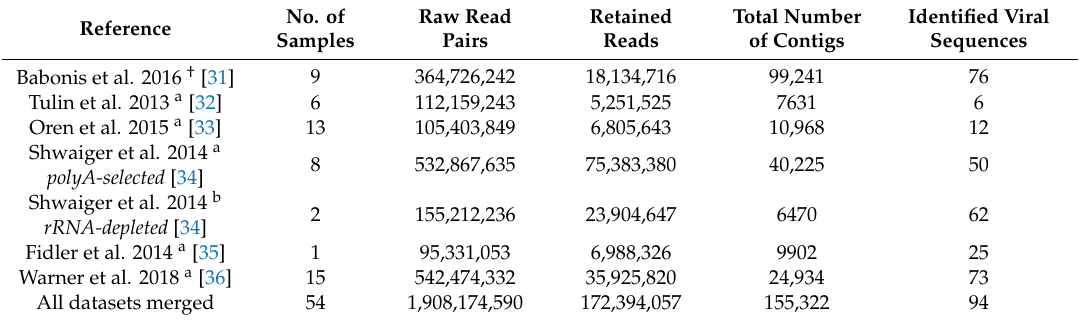
Table 1. Summary of sequence data used for virus identification in RNA-seq studies. Retained reads refer to read counts after quality filtering, trimming, and removal of the Nematostella genome, transfer, mitochondrial and cytoplasmic rRNA, as well as ERCC spike-ins. Identified final viral reads were filtered from the total number of de novo assembled contigs and cleared from